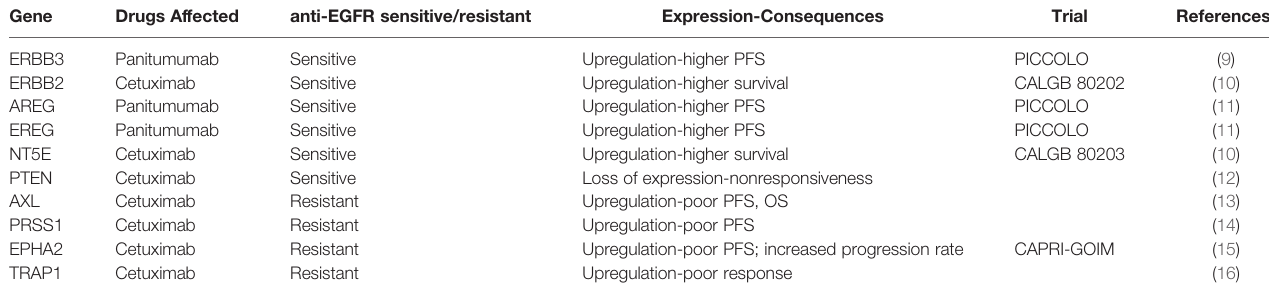
TABLE 1 | Anti-EGFR sensitive/resistant genes at expression level.